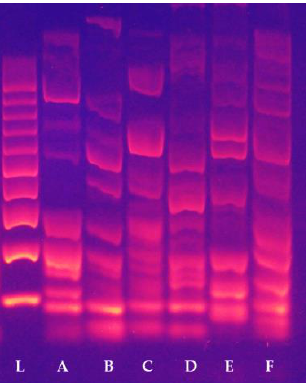
Figure 2. CDDP fingerprint pattern obtained by primer combination WRKY F1/R3. L — 100 bp ladder; A —Grűner Veltliner; B— Weisser Riesling; C — Welschriesling; D — Chardonnay; E — Gewurztraminer; F — Cabernet Sauvignon.